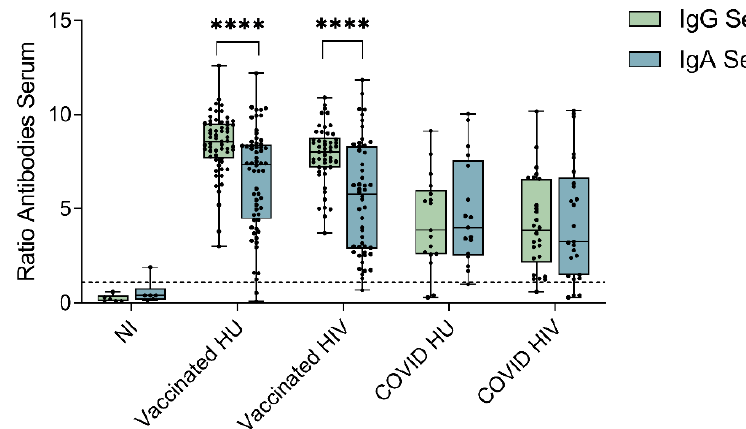
Figure 2. Comparison between the spike-specific IgG- and IgA-levels in serum within BNT162b2 mRNA vaccinated subjects ( n = 110) and COVID-19 convalescent subjects ( n = 43). Medians and interquartile ranges (IQRs) are presented for SARS-CoV-2 non-immune (NI, n = 6), vaccinated HIV-1-uninfected (HU, n = 60), vaccinated HIV-1-infected (HIV, n = 50), COVID-19 HIV-1-uninfected (COVID HU, n = 17), COVID-19 HIV-1-infected (COVID HIV, n = 26). The IgG and IgA levels are presented as antibody ratios obtained by dividing the extinction of the sample by that of the assay calibrator. The cut- off ratio for a positive IgG or IgA level at ≥1.1 is indicated by the dashed line . Significance was tested by Wilcoxon signed-rank tests. All vaccinated and COVID-19 convalescent subjects had significantly higher IgG- ( p ≤ 0.0001) and IgA-levels ( p ≤ 0.001) compared to the NI group ( p -value not depicted in the graph). Significance was tested by Mann–Whitney U tests. **** = p ≤ 0.0001.